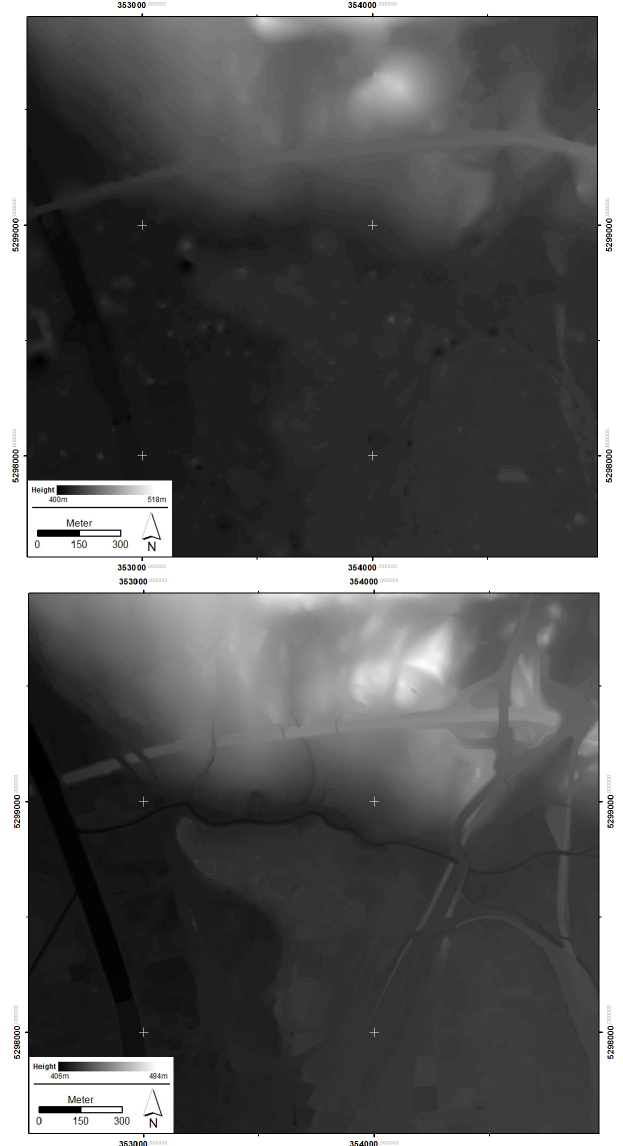
Figure 4. Top : Resulting DEM generated from the stereo-imagery DSM using the presented approach; Bottom : Reference DEM derived from LiDAR